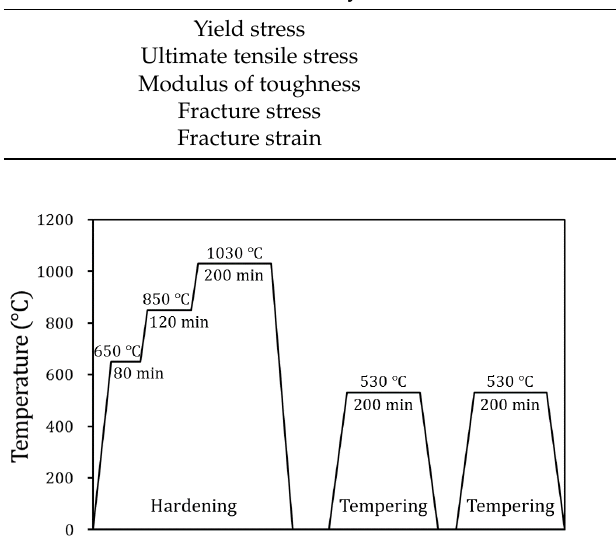
Figure 1. Heat treatment conditions for STD-11 tool steel. Table 3. Chemical compositions of TRIP1180 steel and STD-11 tool steel (wt%).